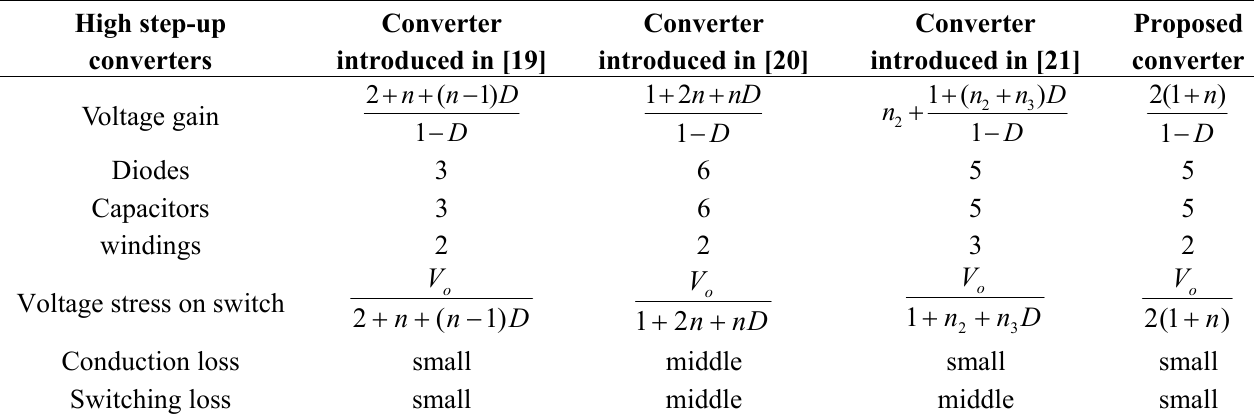
Table 1. Performance comparison of the proposed converter with other high step-up